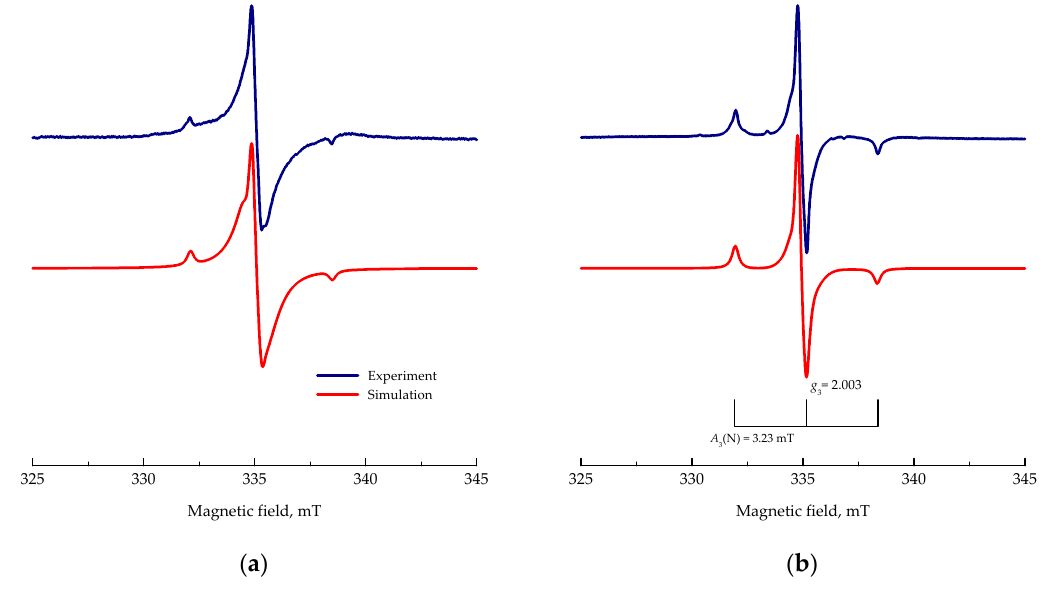
Figure 3. Experimental X ‐ band EPR spectra (blue) measured at 100 K upon visible ‐ light exposure (7 ‐ min, 160 klx) of ( a ) M3 and ( b ) M4 powders along with their simulations (red) calculated as superposition of single ‐ line ( g = 2.003) and nitrogen bulk centers (N b• , g 1 = 2.005, g 2 = 2.004, g 3 =